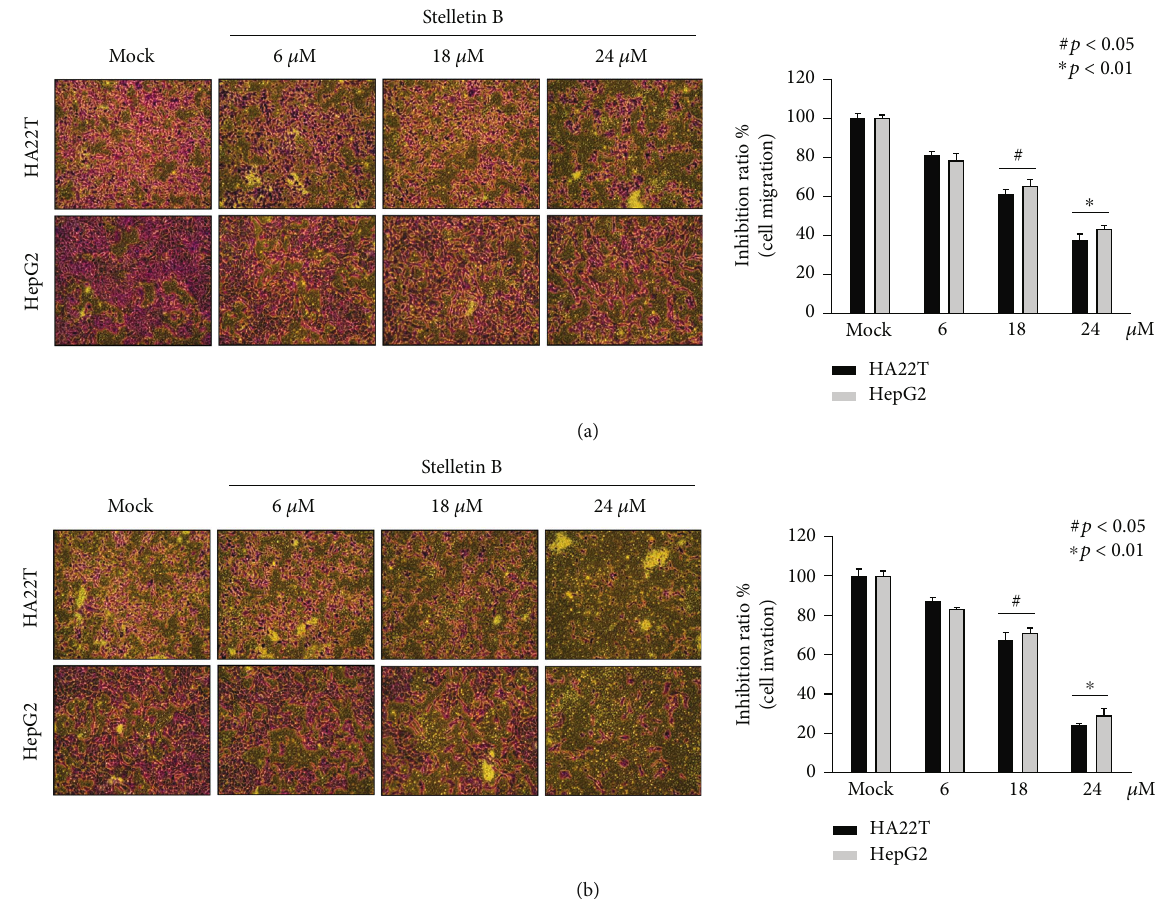
Figure 3: Stellettin B inhibited HA22T and HepG2 cell migration and invasion. (a) Stellettin B inhibited HA22T and HepG2 cell migration; (b) Stellettin B inhibited HA22T and HepG2 cell invasion. Mock refers to cells treated with DMSO vehicle as a control ( n = 3 ; three independent experiments). ( 100 × magnification